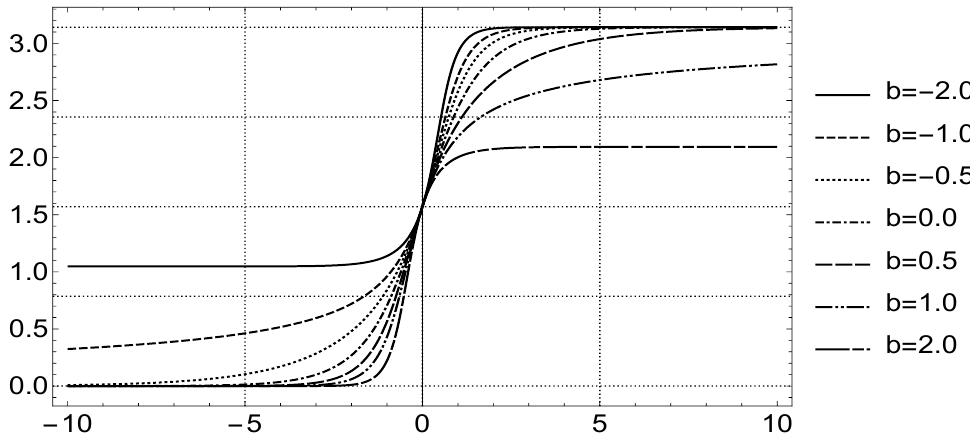
Figure 1 . Plots of ’ ( x ) against x for solutions of the equation (4.8) with the upper sign and with x rescaled as x ! (cid:13) 1 x . The curves correspond to solutions of (4.8) for di(cid:11)erent values of the ratio b = 4 (cid:13) 2 and the initial condition ’ (0) = (cid:25) . (cid:13) 1 2 between the vacua ’ (vac : ) = 0 and ’ (vac : ) = (cid:25) . For j b j > 1 the solution connects ’ (vac : )